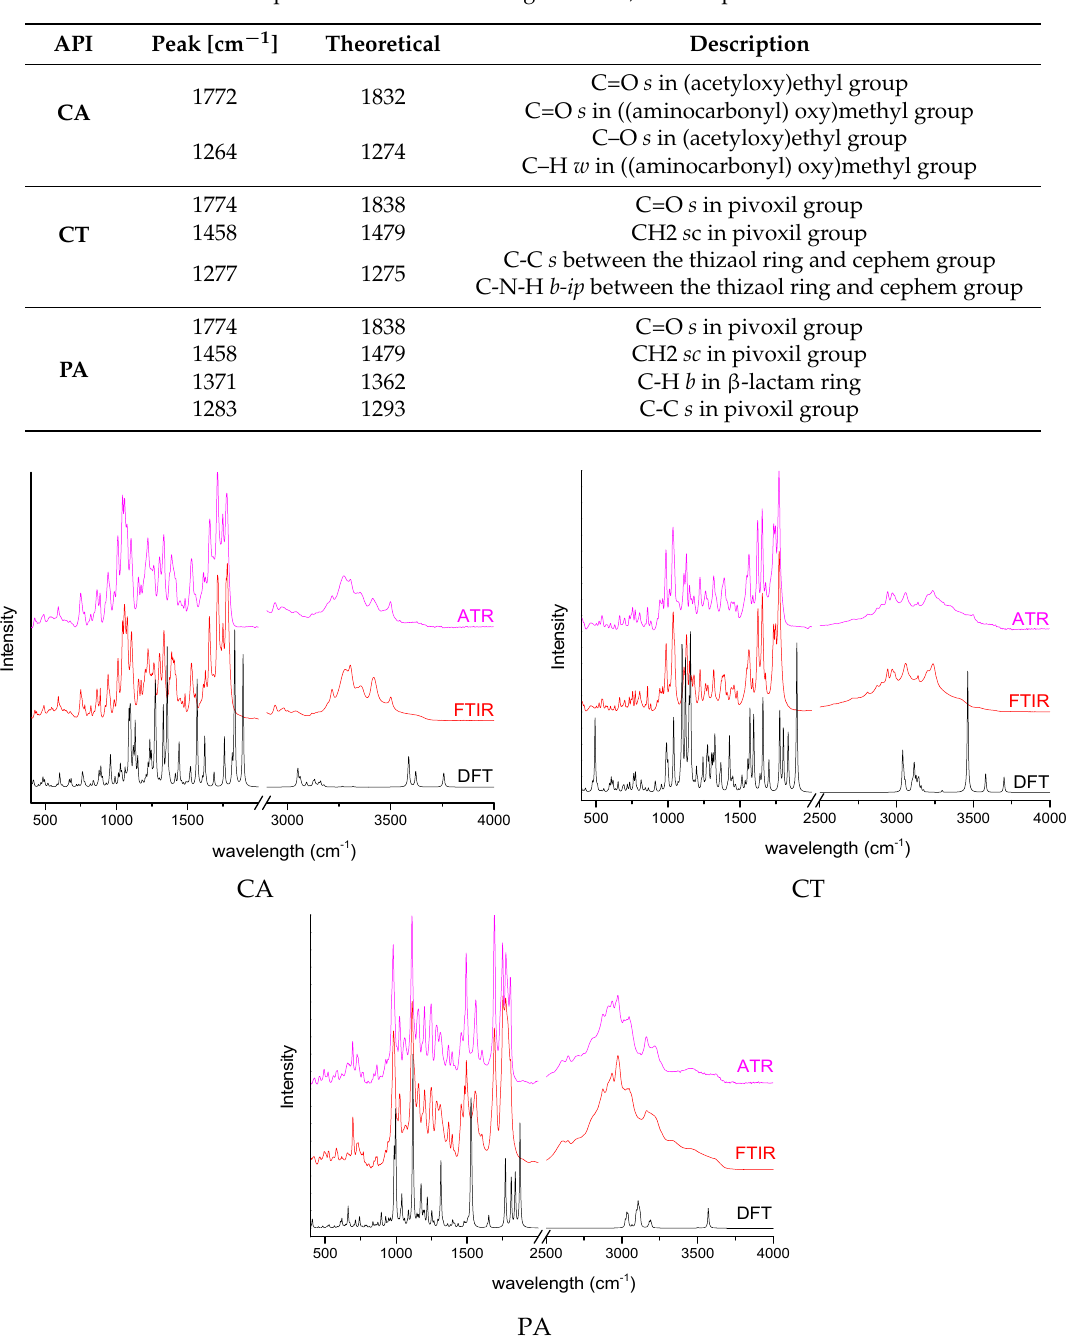
Figure 2. Experimental and theoretical spectra of CA, CT, and PA.